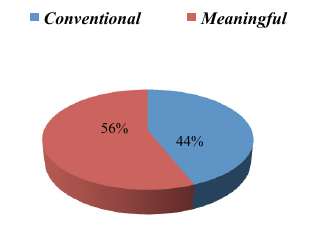
Figure 3. Teaching methods in the classroom: teaching methods based on meaningful learning versus traditional teaching.